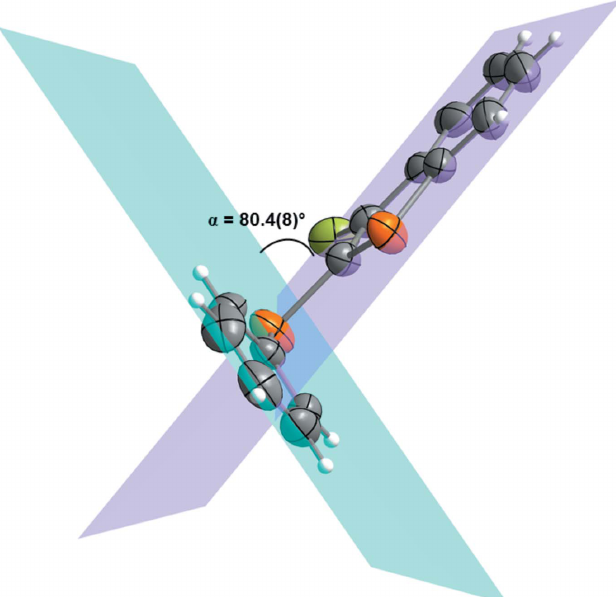
Figure 7 Representation of the interplanar angle ( (cid:4) ) between the planes containing the phenylselanyl, blue plane, and the benzo[ b ]selenophene, purple plane, groups for 3-bromo-2-(phenylselanyl)benzo[ b ]selenophene ( 3 ). Displacement ellipsoids are drawn at the 50% probability level. Gray: carbon; orange: selenium; light green: bromine; white: hydrogen.